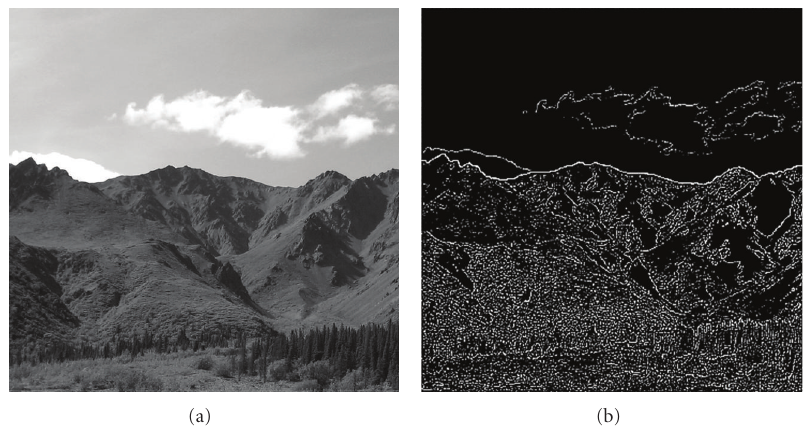
Figure 14: The original image and the image after applying Canny edge detection.